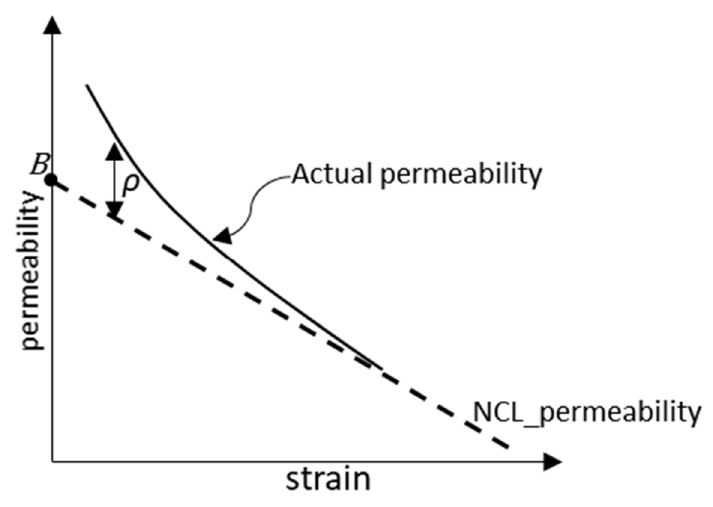
Figure 25. Permeability approaching the NCL_permeability.